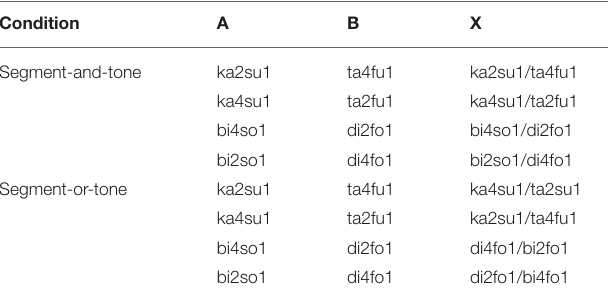
TABLE 2 | Arrangement of stimuli in ABX